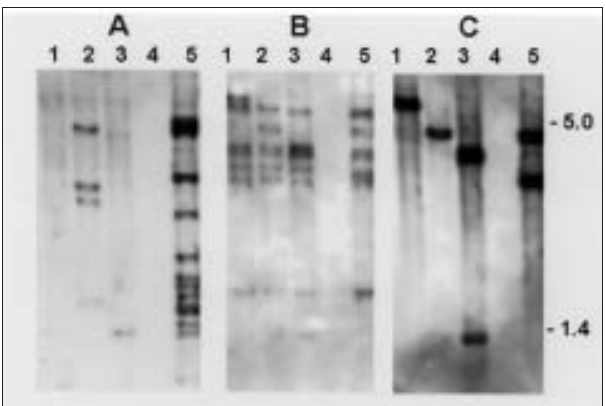
Figure 1) Restriction fragment length polymorphism analysis of My- cobacterium tuberculosis strains. A Southern blot of Pvu II-digested DNA was probed for IS 6110 , panel A; IS 1081 , panel B; direct repeat, panel C. Lane 1, S384; lanes 2 and 3, clinical isolates; lane 4, blank; lane 5, H37Rv (ATCC 27294). Sizes are indicated in kilobase pairs and were determined from known sizes of IS 6110 -containing fragments from H37Rv. The same area of the blot is shown in each